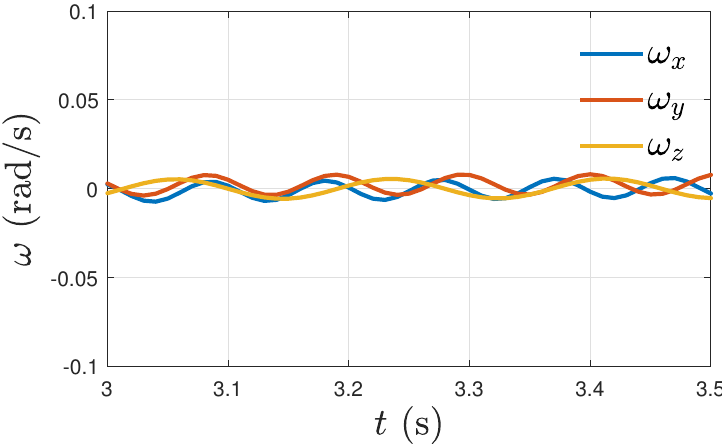
Figure 15. Zoomed-in plot of components of ω under the influence of the disturbance torque.